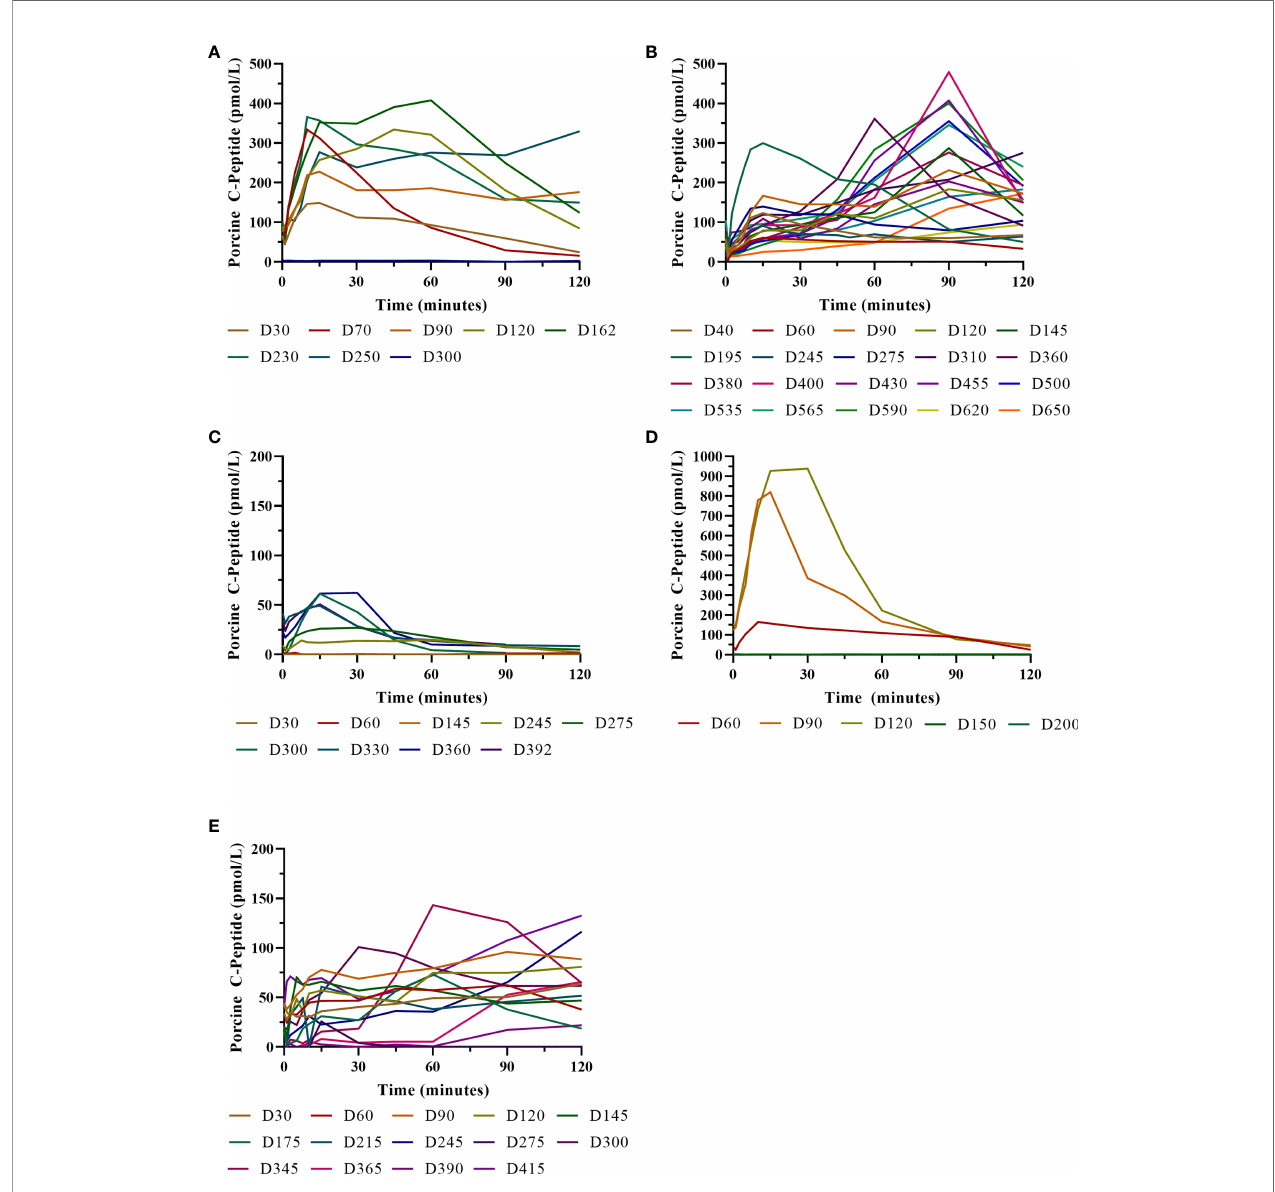
FIGURE 7 | Porcine insulin and c-peptide levels during IVGTTs after NICC transplantation. Recipients S1 (A) , B1 (B) , F1 (C) , W1 (D) , O1 (E)